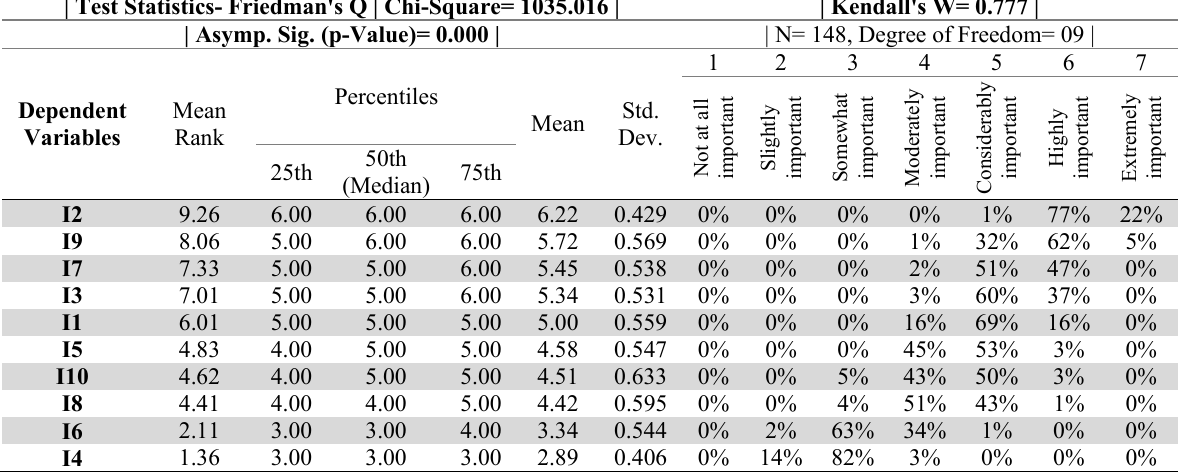
Friedman Q and descriptive statistics- Level of importance towards the future plans and strategies | Test Statistics- Friedman's Q | Chi-Square= 1035.016 |